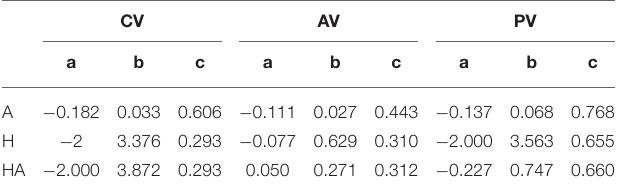
TABLE 1 | Parameters of the fitted exponential curves: (a) leading value, (b) learning rate, and (c) asymptote. CV AV